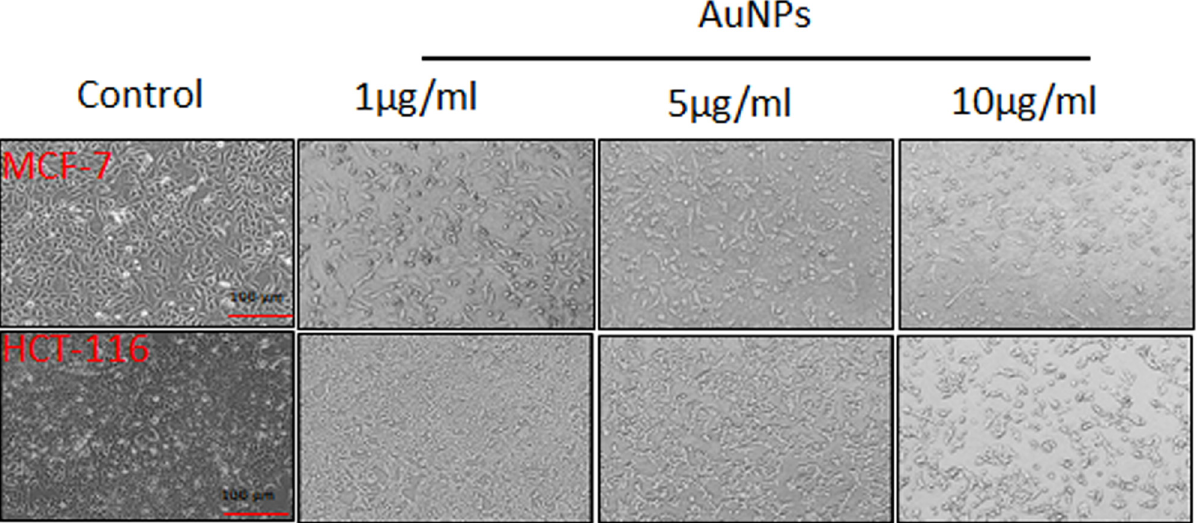
Figure 3: MCF - 7 and HCT - 116 cells were treated with increasing concentrations of AuNPs for 24 h and showed morphological alterations. The images were captured using a Leica microscope at 10 × magni fi